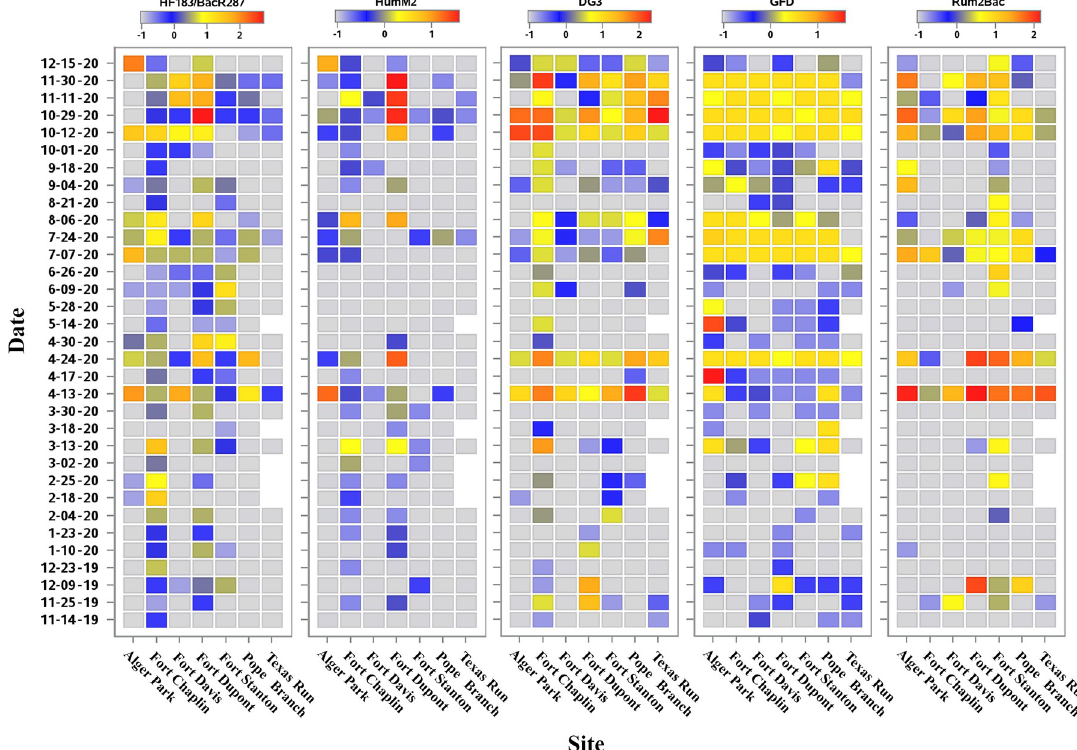
Fig 4. Host-associated qPCR genetic marker estimated log 10 copies per reaction concentrations for HF183/BacR287, HumM2, DG3, GFD, and Rum2Bac. Heatmap keys are shown for each qPCR assay data set indicating estimated log 10 copies per reaction color coding information. Sampling date and site combinations denoted by a white cell represents samples that failed the sample processing control and were discarded from the study. Cells shaded grey indicates samples where all sample replicate reactions yielded a C q = 40